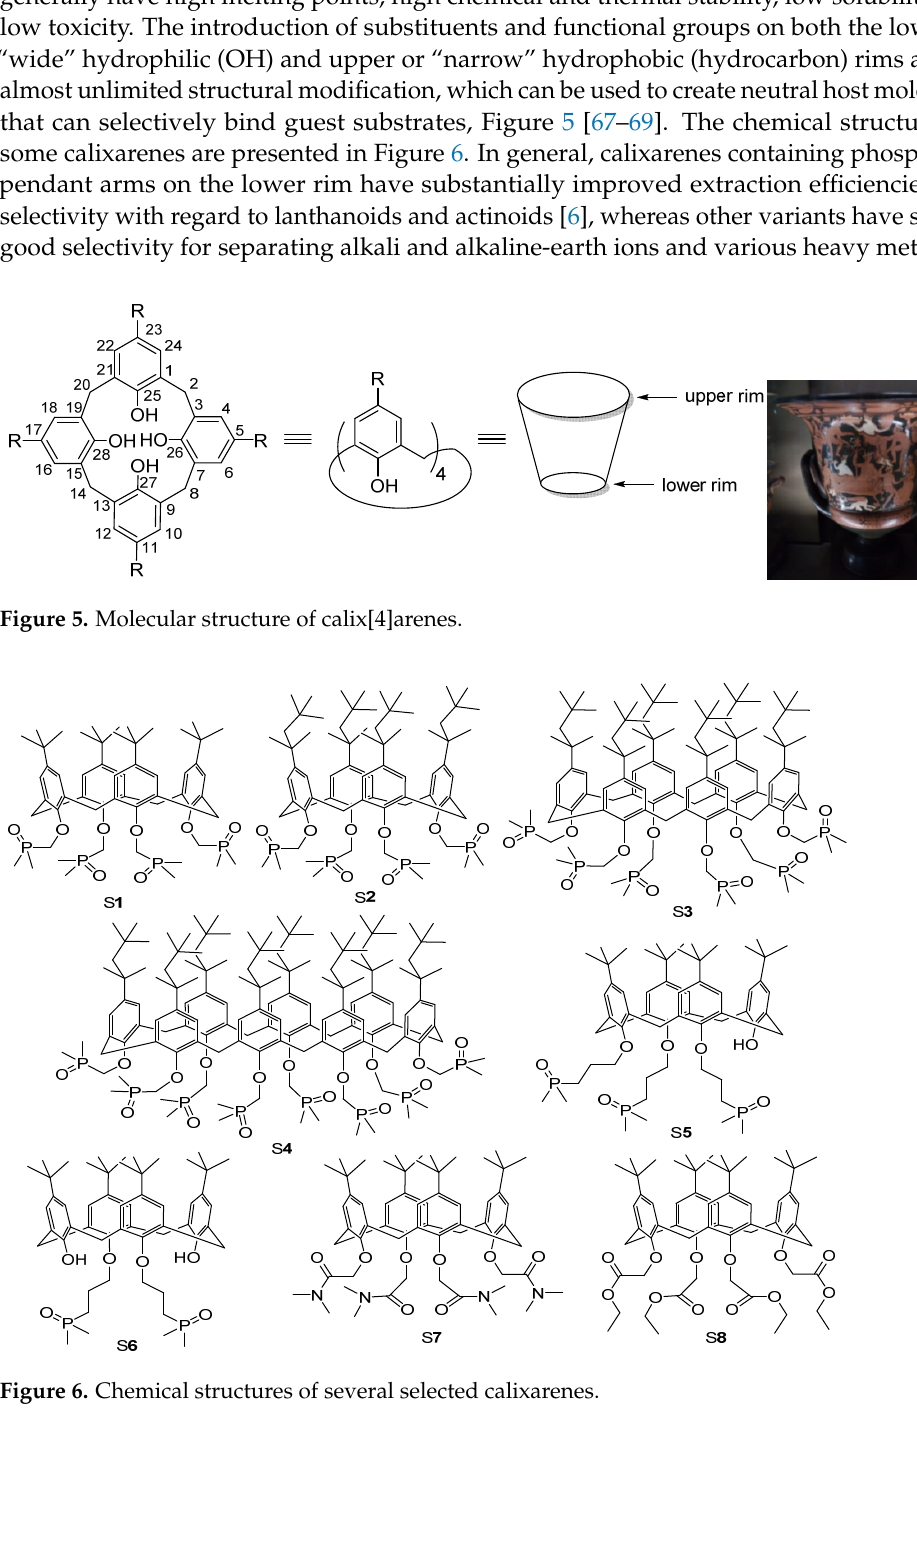
Figure 6. Chemical structures of several selected calixarenes.